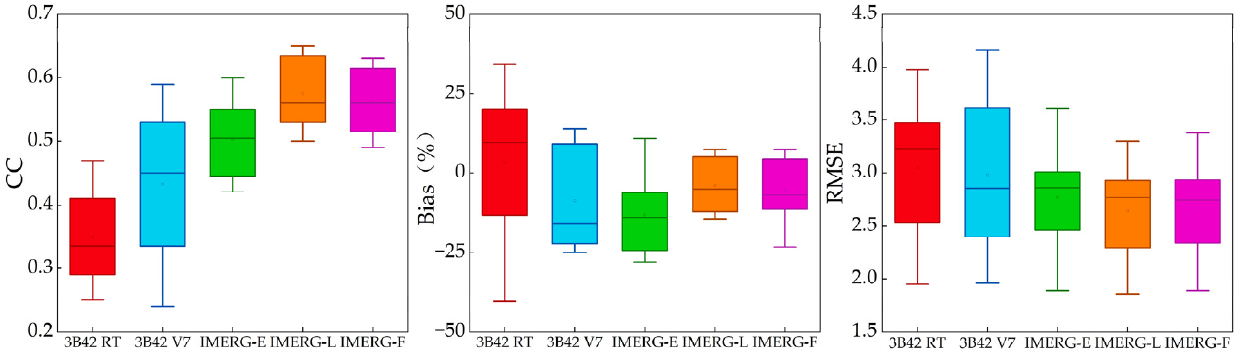
Figure 4. Boxplots of statistical metrics of eight precipitation events for the five SPPs over the Mishui basin. The upper and lower edges of the box mark the upper and lower quartiles (75% and 25%, respectively); the solid line in the box marks the median value; the upper and lower horizontal lines outside of the box mark the range in 1.5 IQR; and the square point marks the average value.